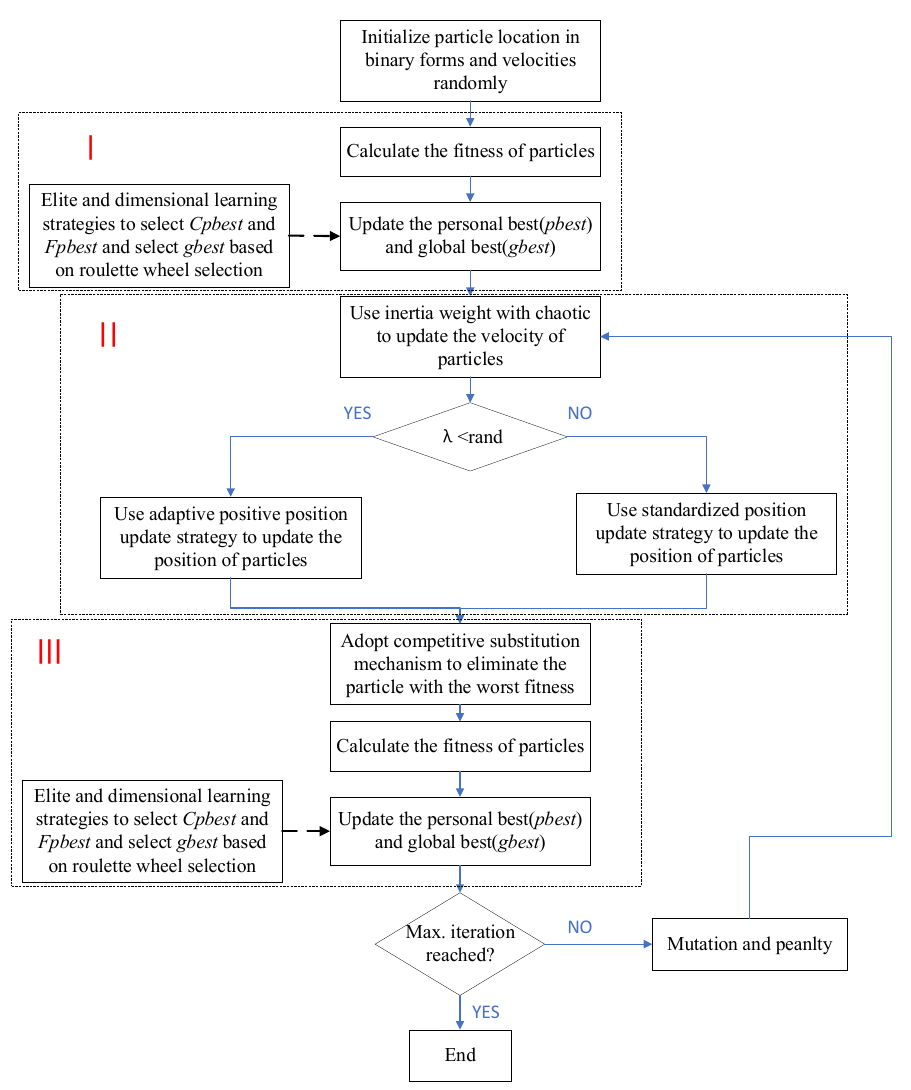
Figure 6. Flow chart of modified